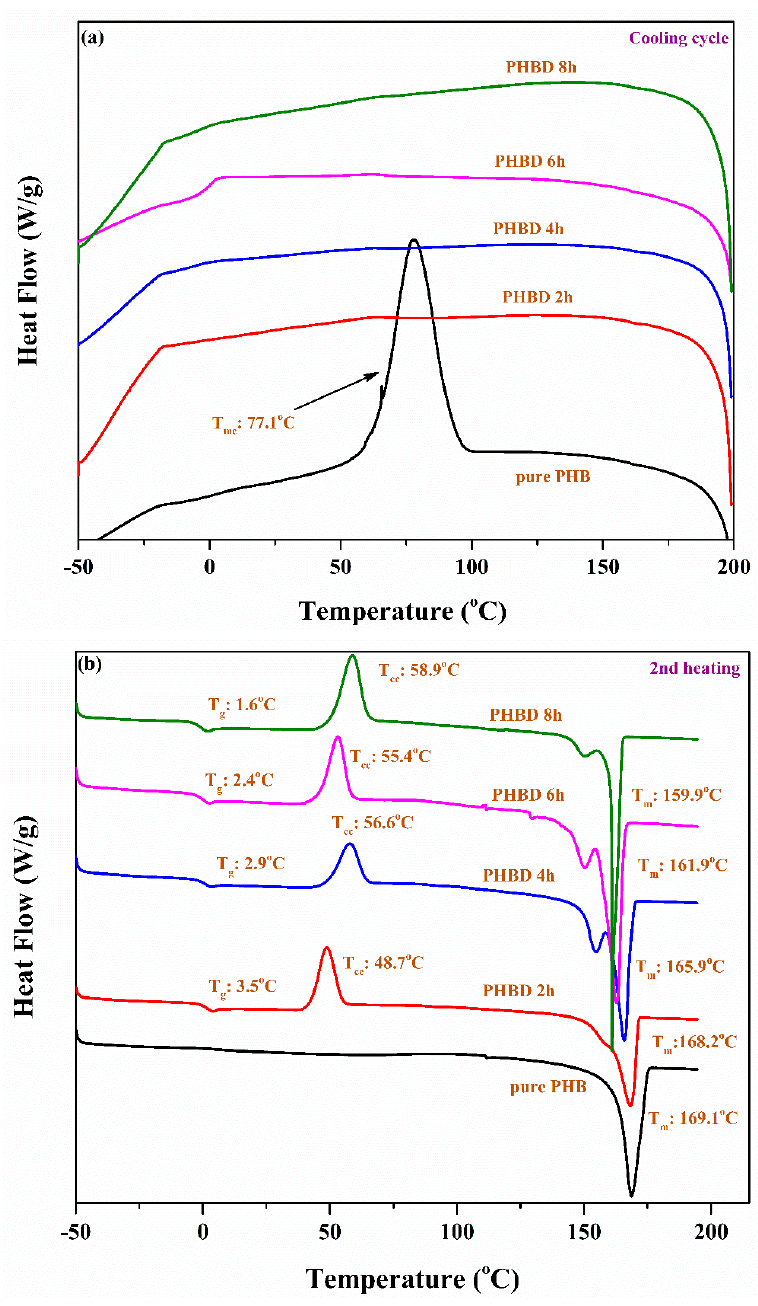
Figure 3. ( a ) Cooling curves and ( b ) 2 nd heating curves of PHBDs.